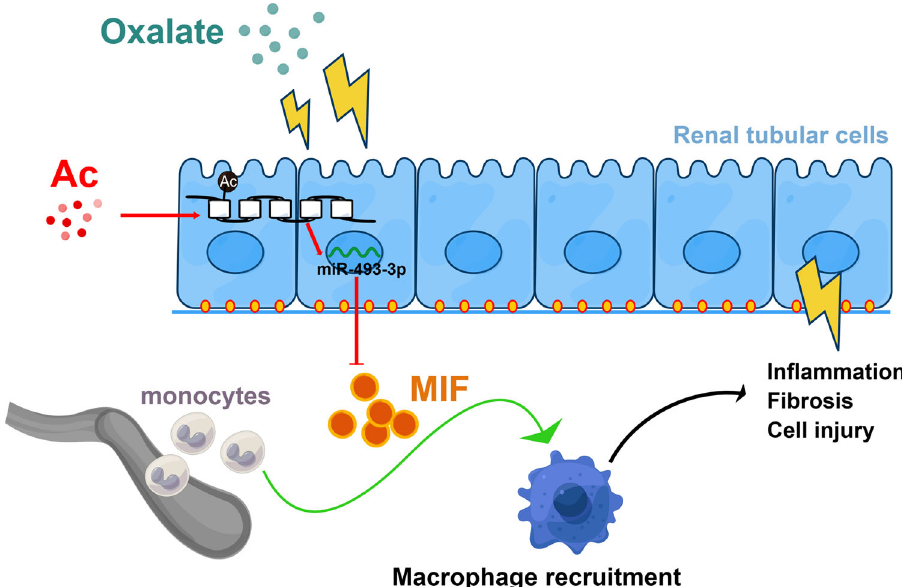
Fig. 7 A scheme of acetate effect. The scheme diagram summarizes the pathway described: acetate enhances the H3K9 and H3K27 acetylation levels at miR-493-3p promoter region, which downregulate MIF expression, and decrease macrophages in fi ltration to attenuate the hyperoxaluria-induced renal injury. The fi gure was created by